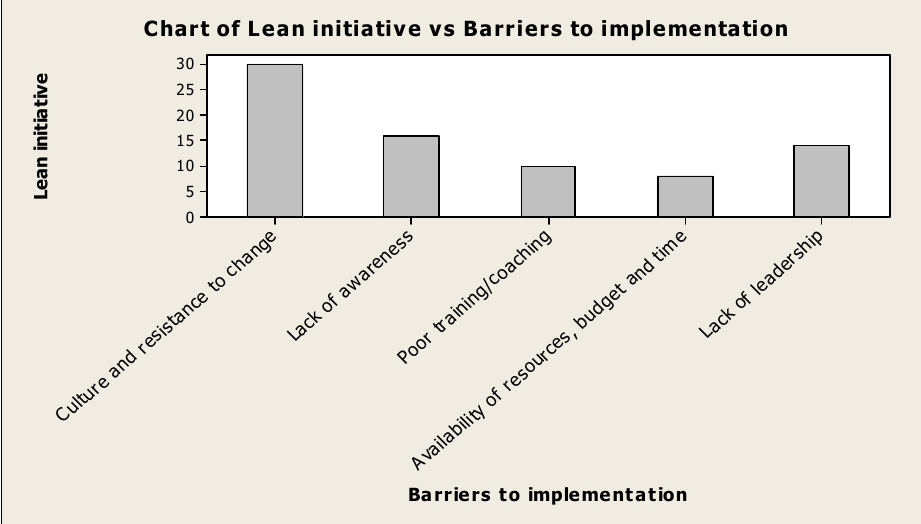
Figure 2 – Barriers to implementation of Lean